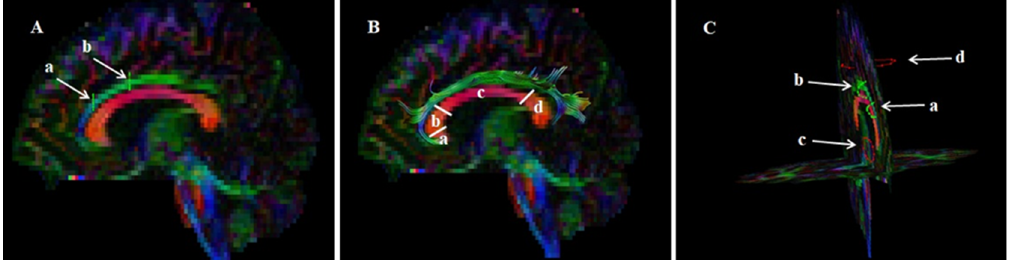
Figure 1. Diffusion tensor imaging tractography of the cingulum bundle with fractional anisotropy color maps. Green, red, and blue colors represent fibers running along the axis (anterior–posterior, left–right, and superior–inferior, respectively). ( A ) sagittal slice with the location of two regions of